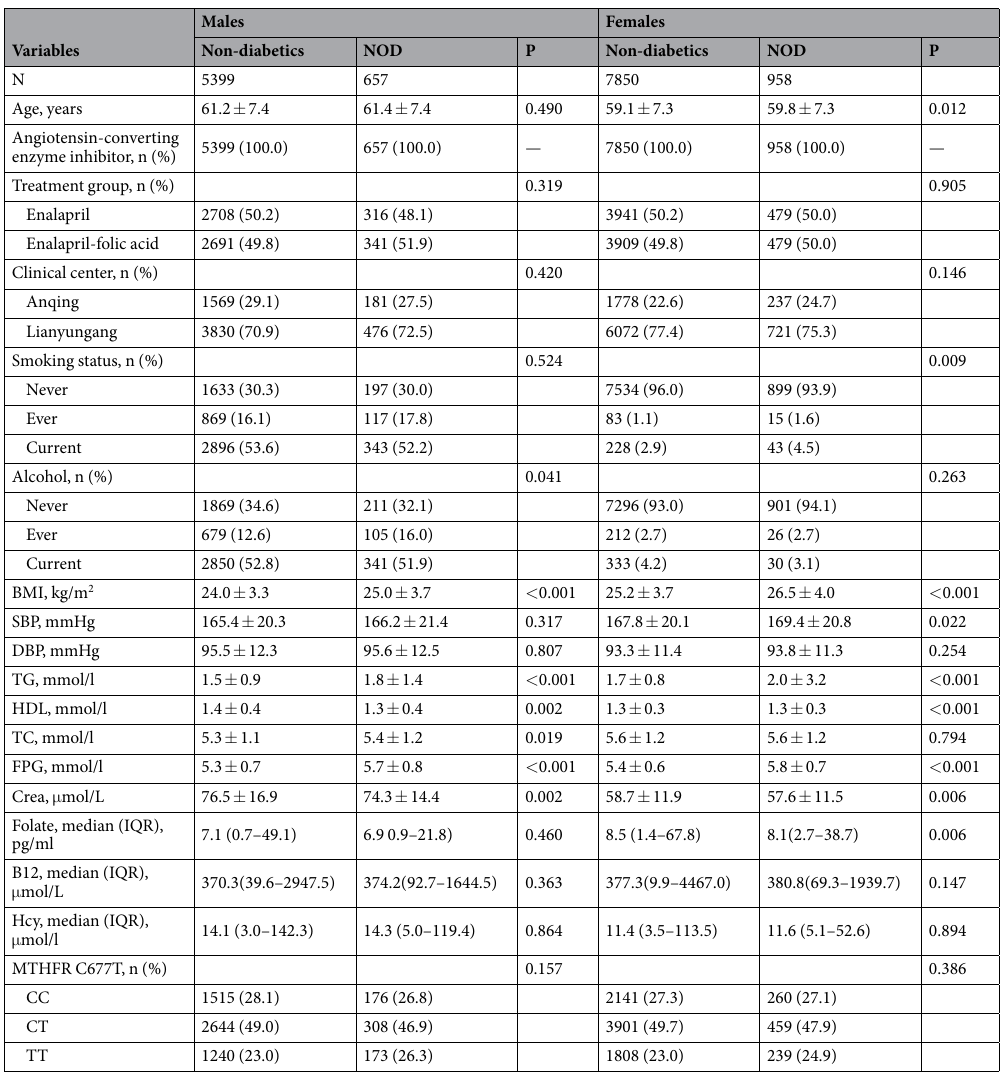
Table 1. Characteristics of the participants. Continuous variables are presented as mean ± SD or median (IQR), while categorical variables are presented as n (%). Abbreviations: SBP = systolic blood pressure, DBP = diastolic blood pressure, TG = triglycerides, HDL = high-density lipoprotein, TC = total